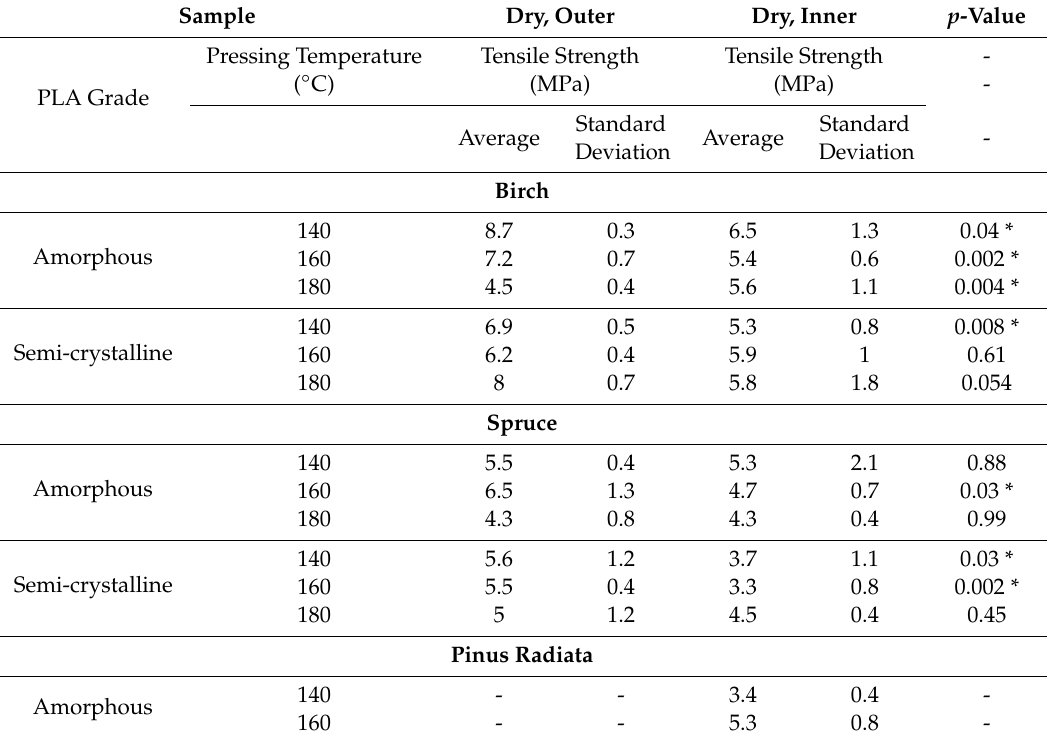
Table 2. Summary of tensile testing results for inner and outer bondlines of laminated panels tested dry. Sample Dry, Outer Dry, Inner p -Value Pressing Temperature Tensile Strength Tensile PLA Grade